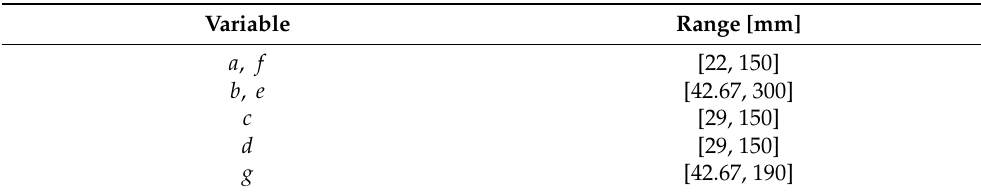
Table 3. Input data variation ranges. Source: the